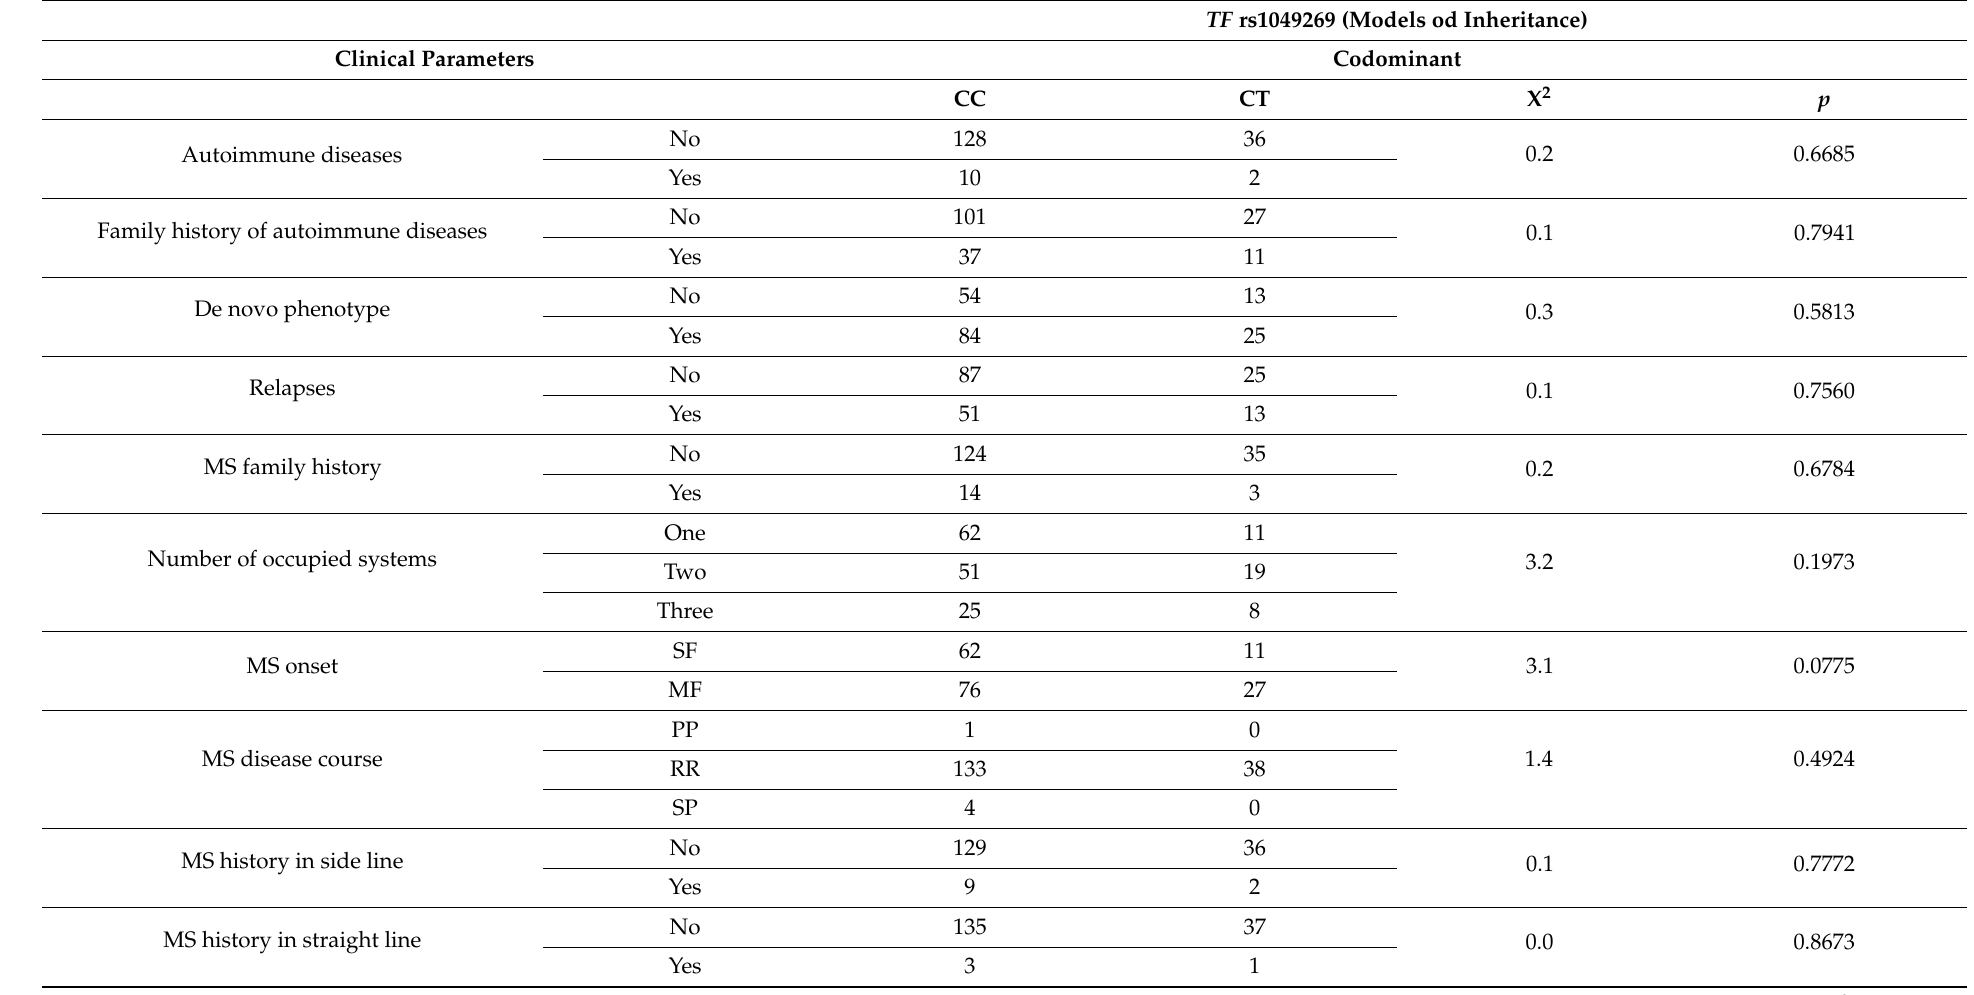
Table 11. Analysis of the relationship between the rs1049269 TF polymorphism and selected clinical parameters.